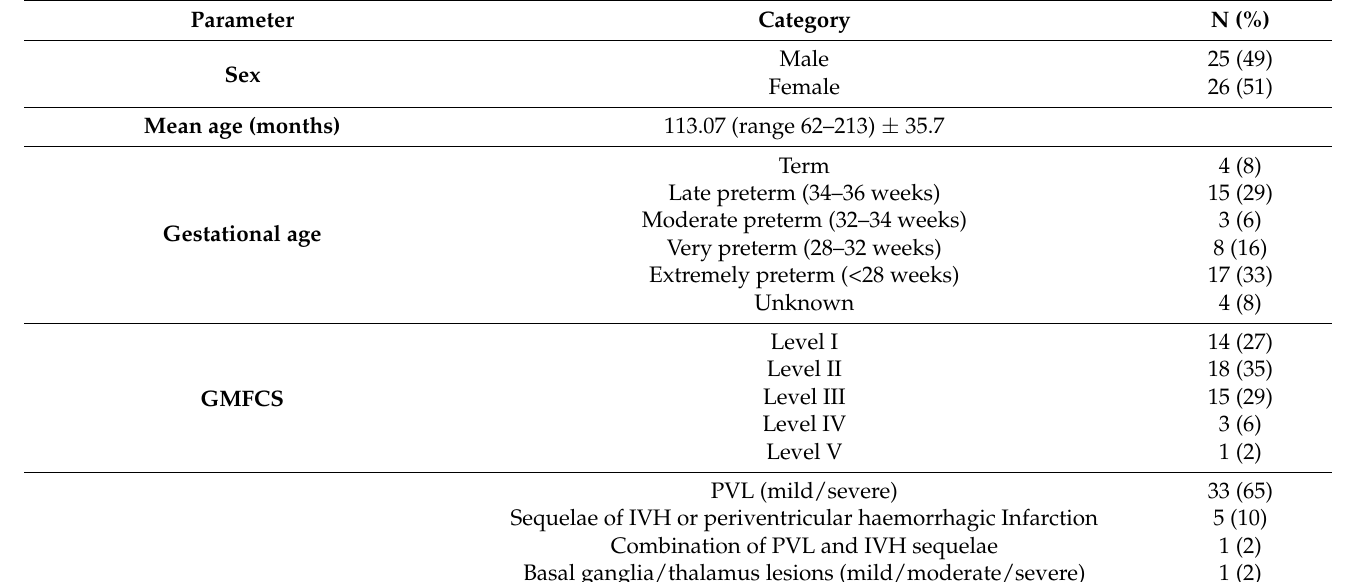
Table 1. General characteristics of the sample. GMFCS: Gross Motor Function Classification System. PVL: Periventricular Leukomalacia. IVH: Intraventricular Hemorrhage. CNS: Central Nervous System. N =